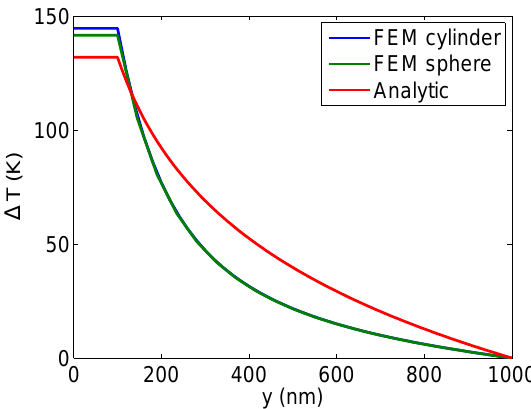
Figure 16: Temperature elevation along y axis for a sphere and an infinite cylinder along x direction. Finite element and analytical results for the sphere are